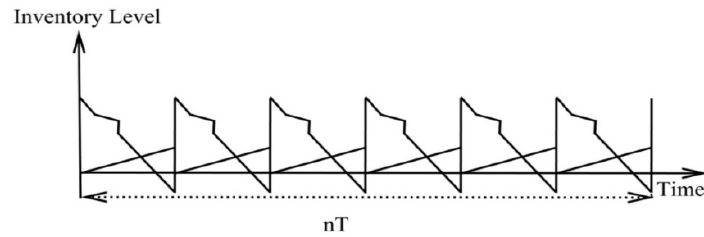
Figure 8. Buyer’s inventory representation for n th cycle.